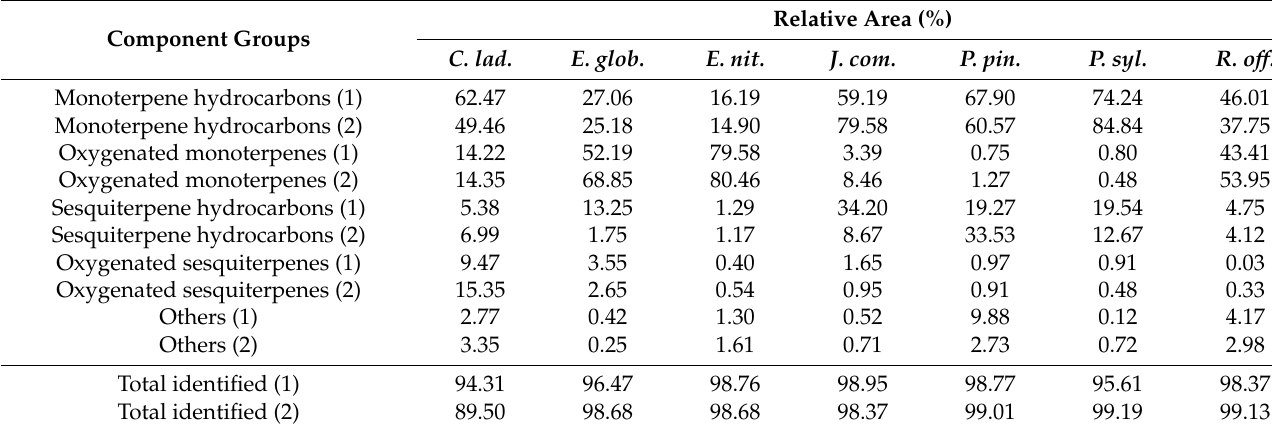
Table 2. Component groups of the essential oil samples from plants collected in the first (1) and second (2) periods and analyzed by GC–MS and